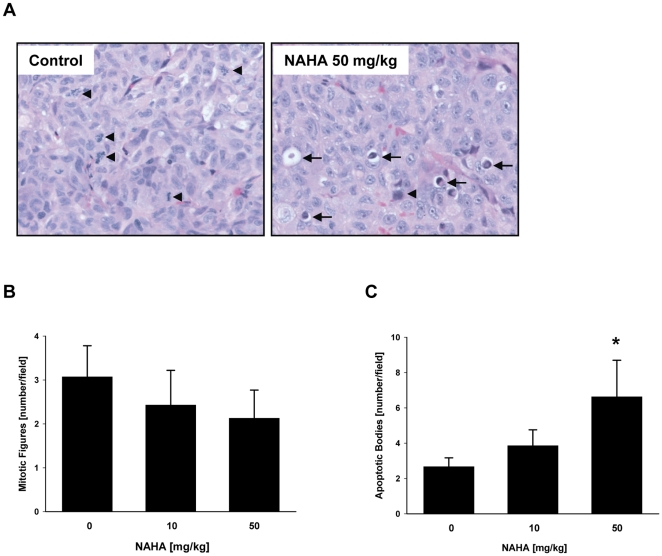
Histology of MDA-MB-231 xenografts.Tumors dissected from animals were sectioned and stained with (A) H&E, and (B) mitotic figures (arrowheads), and (C) apoptotic bodies (arrows) evaluated as described in
Materials and Methods
.